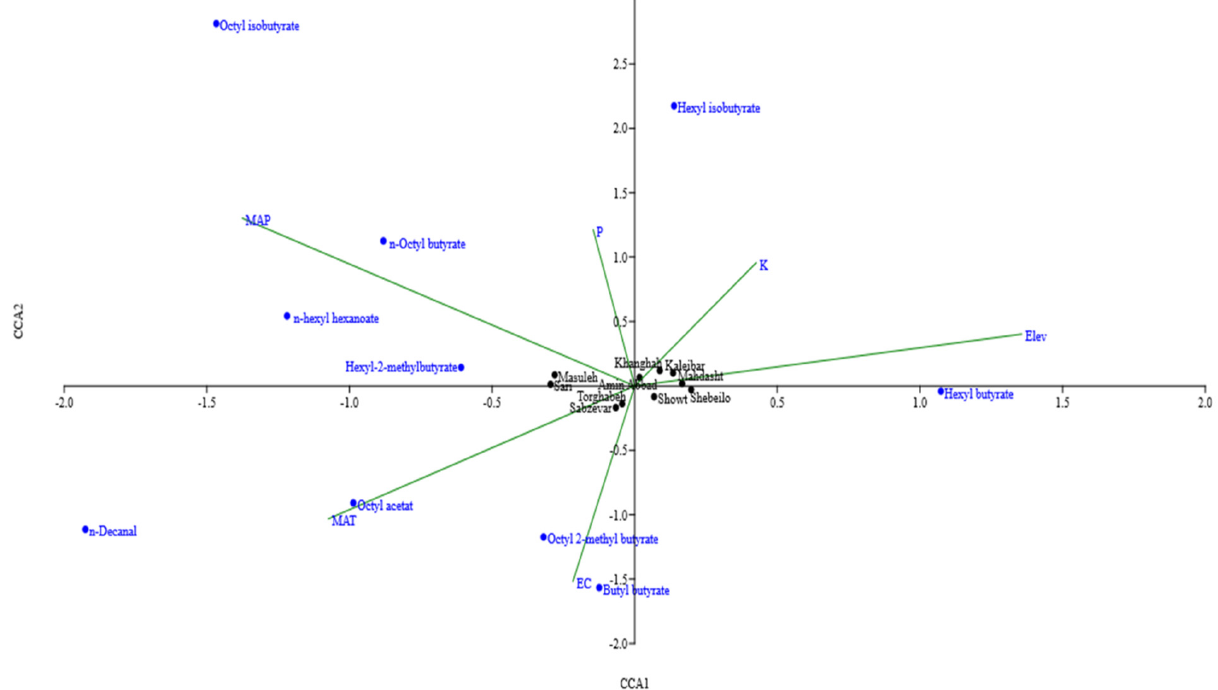
Figure 4. Canonical correspondence analysis biplot of H. persicum populations, linking percentages of the major components, collected site and their climatic characteristics. Table 3. Canonical coefficients, eigen-values, estimated and cumulative variance for four CCA sets between phytochemicals with environmental factors.